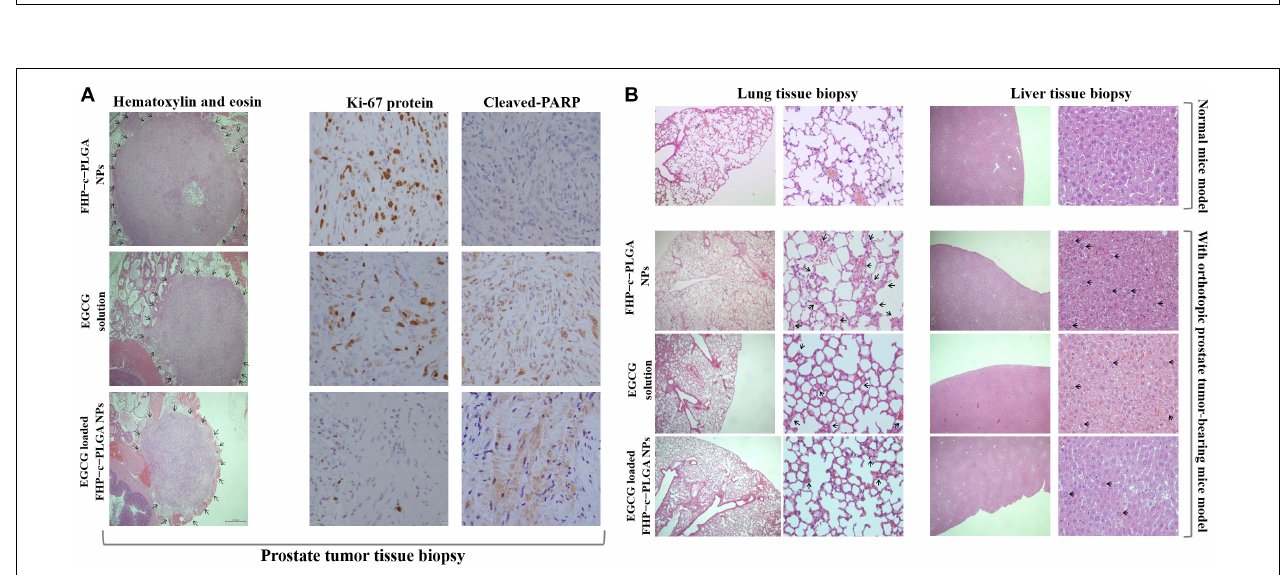
), or EGCG-loaded FHP–c–PLGA NPs ( (cid:78) ) every (cid:32)